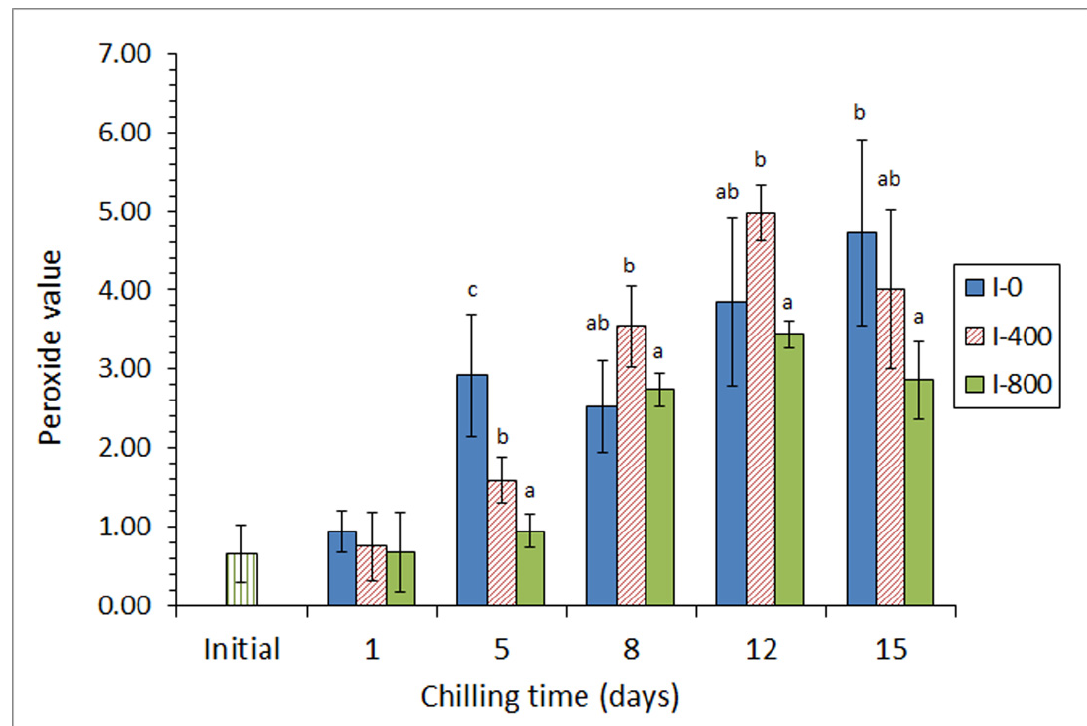
Figure 2. Peroxide formation * in chilled hake subjected to different icing conditions **. * Average values of three independent determinations ( n = 3). Standard deviations are indicated by bars. Average values accompanied by different letters indicate significant differences ( p < 0.05). ** Icing conditions: I-0 (traditional ice; control), I-400 (ice including a low concentration of the acid mixture), and I-800 (ice including a high concentration of the acid mixture). Adapted from García-Soto et al. [45].